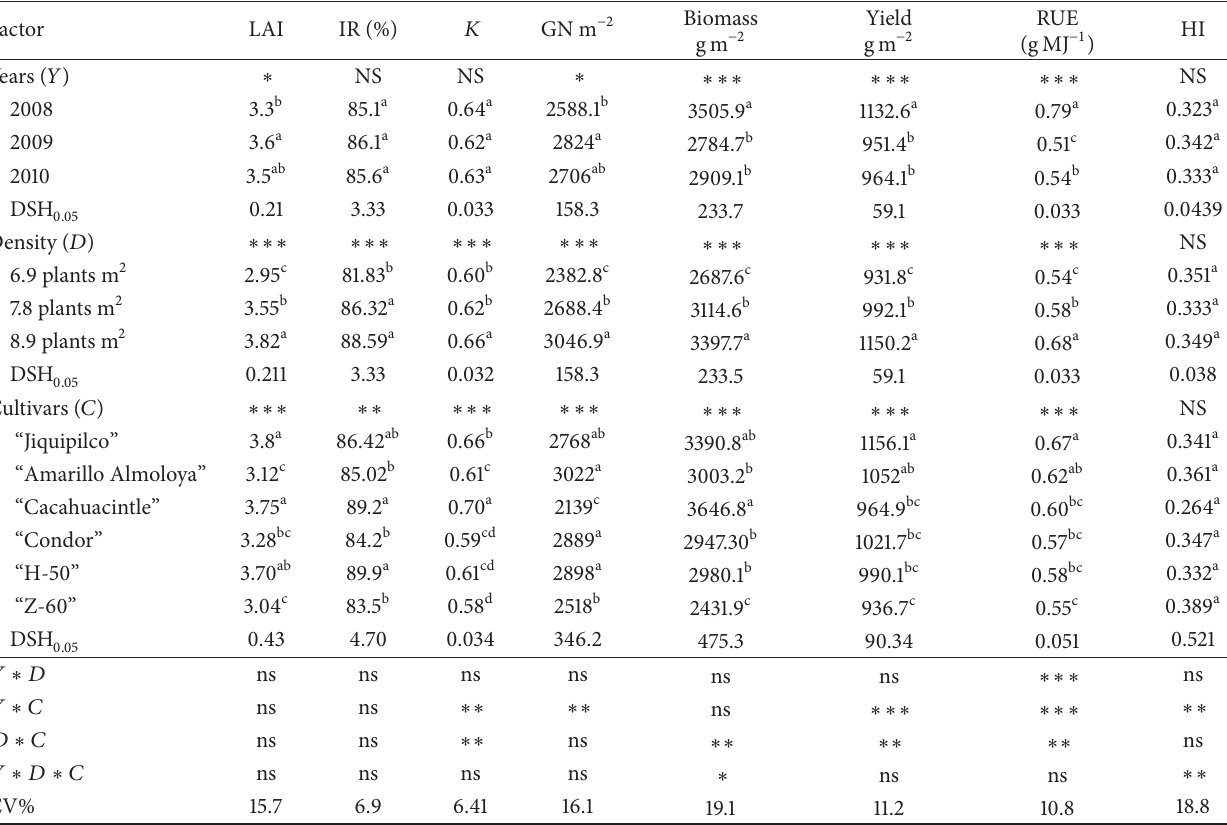
Table 1: Analysis of variance and mean separation densities of three to six maize cultivars evaluated in years 2008, 2009, and 2010. Factor